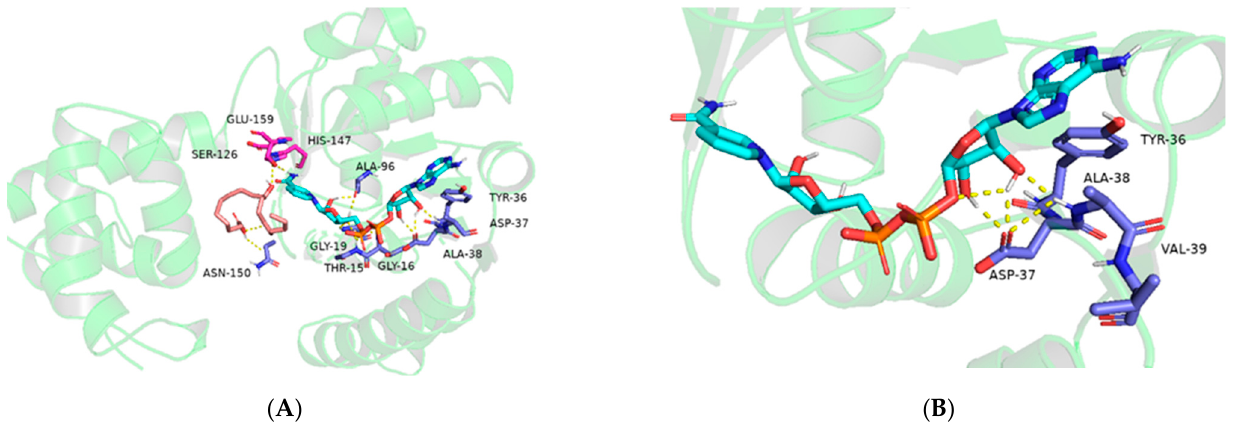
Figure 1. Homology modeling and docking analysis of the wildtype Ml ADH complexed with NAD + . ( A ) Enzyme conformation when binding NAD + to substrate. ( B ) Binding force analysis of NAD + and enzyme.